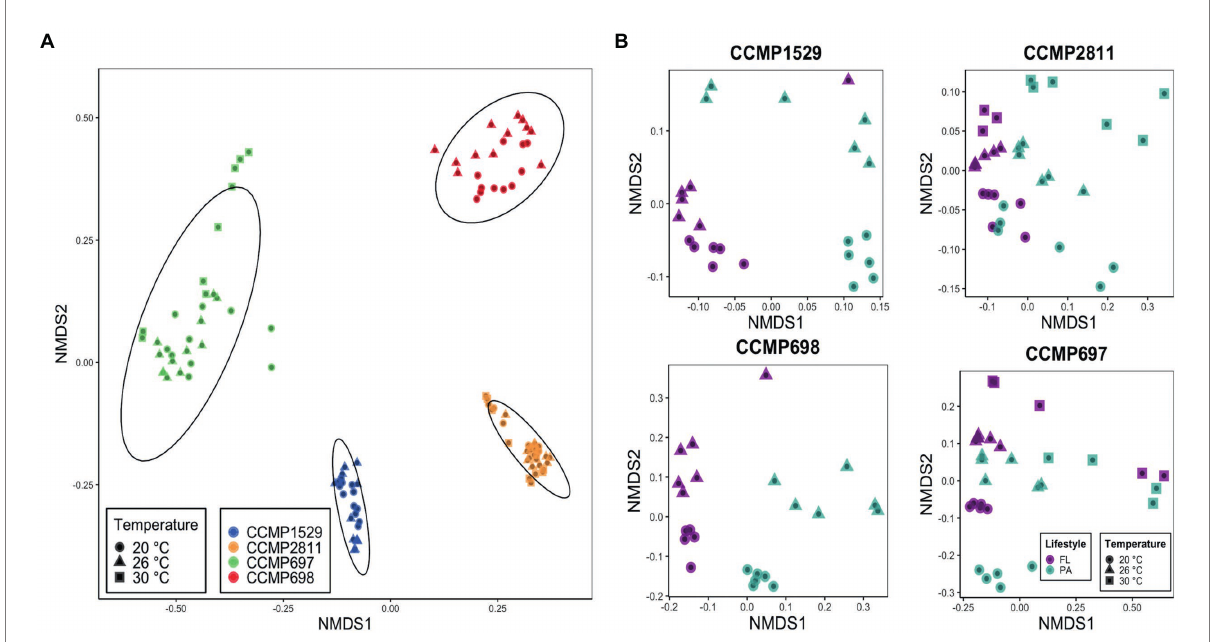
FIGURE 1 Non-metric multidimensional scaling (NMDS) plots analyzed with Bray–Curtis distance matrices based on Hellinger transformed ASV counts. (A) Dissimilarities across Prorocentrum cordatum strains’ bacterial communities. Ellipses represent 95% confidence interval of the standard error of the points from the centroid of the clusters. (B) Dissimilarities within the bacterial communities of each P. cordatum strains. Stress for all ordinations: